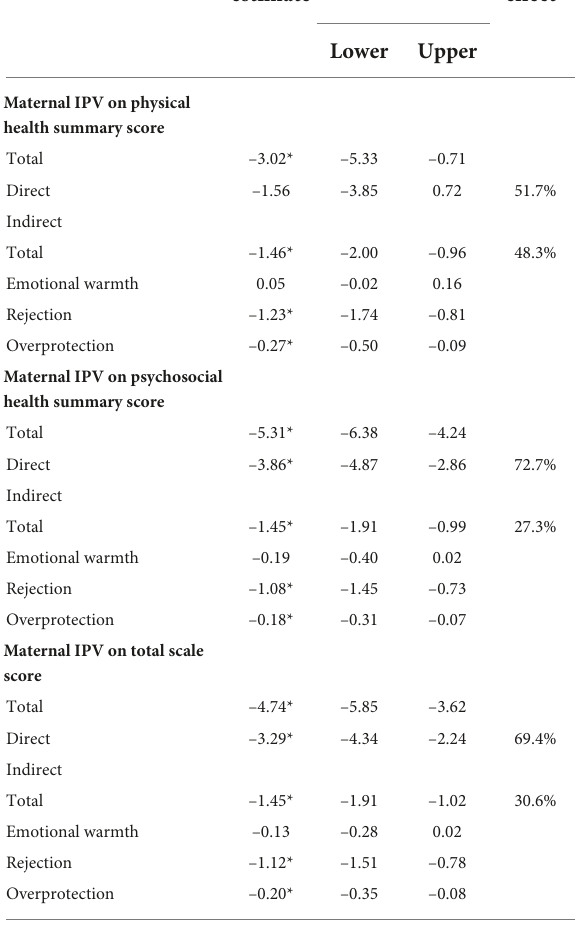
TABLE 3 Mediating effect of parenting styles between maternal IPV and summary scores of children’s